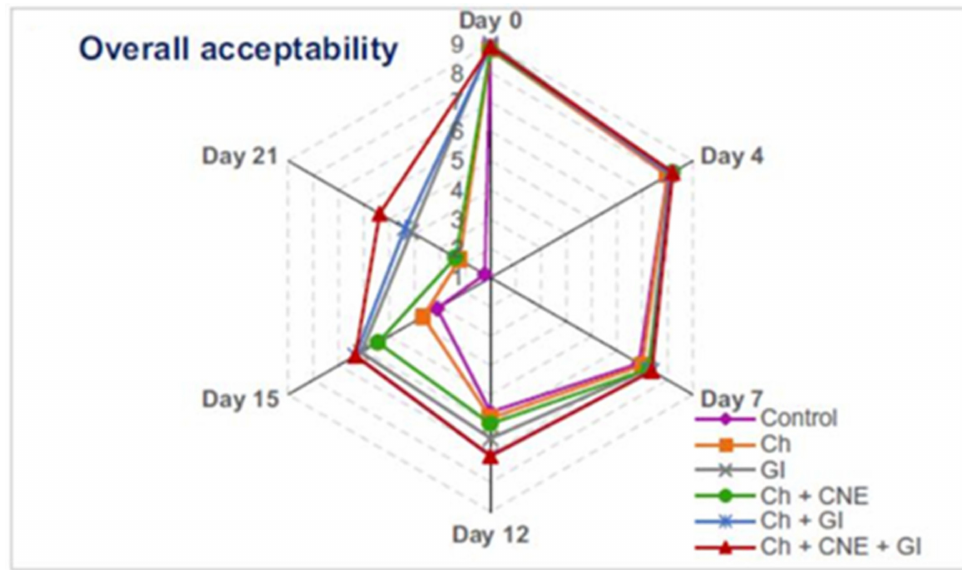
Figure 3. Changes in overall acceptability (based on appearance, odor, and texture) of beef loins treated with chitosan (Ch), cumin essential oil nano-emulsion (CNE), and gamma irradiation (GI) during chilled storage. Adapted from [94]; Copyright 2021